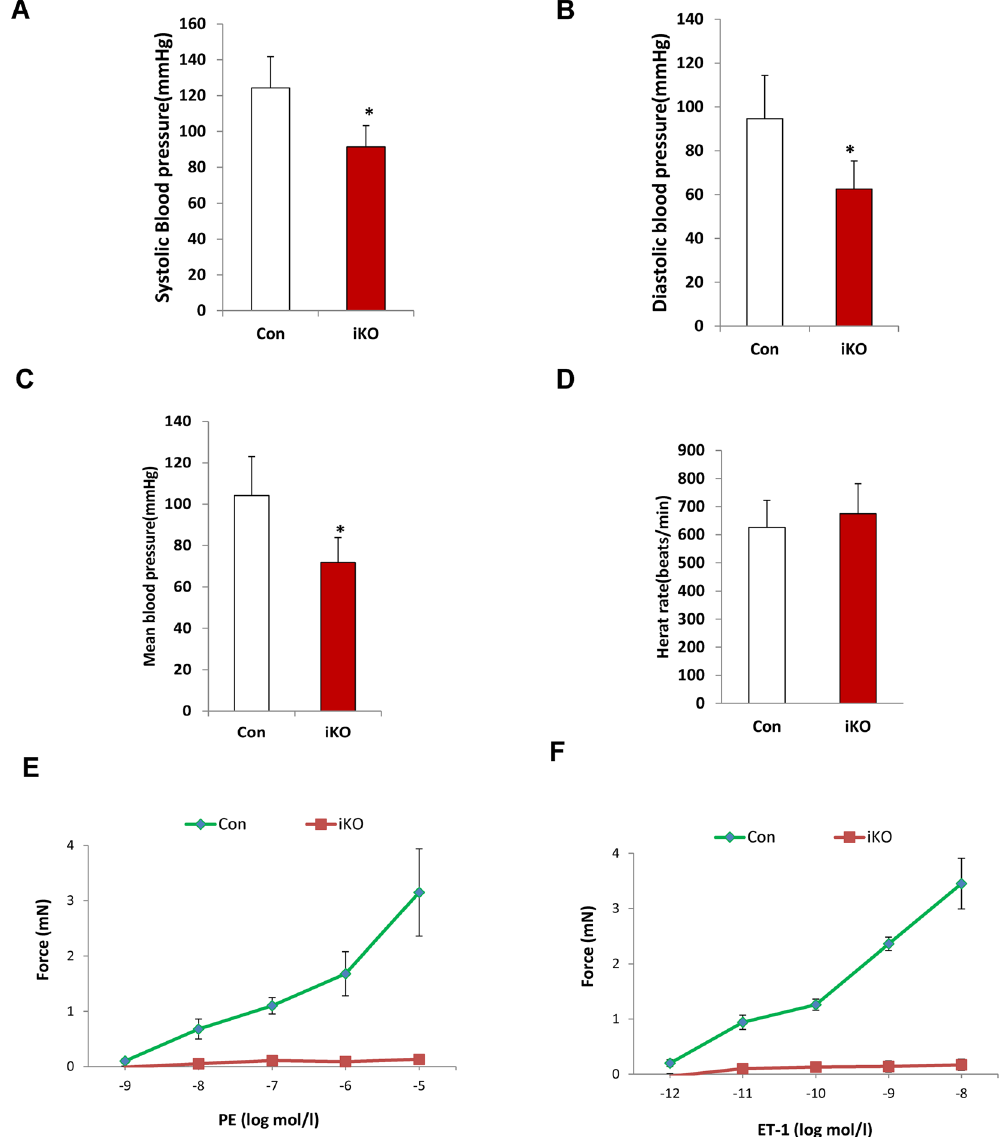
Figure 2. DGCR8iKO mice displayed reduced blood pressure and vascular reactivity. ( A,B,C ) Blood pressure was measured in DGCR8iKO and control mice one month after tamoxifen injection using tail-cuff method. DGCR8iKO mice displayed significantly reduced blood pressure including systolic ( A ), diastolic ( B ) and mean ( C ) compared to controls (N = 5 per group, * p < 0.05). ( D ) DGCR8iKO mice didn’t display significant differences in heart rate compared to controls. ( E and F ) The vascular reactivity was measured in thoracic aorta isolated from DGCR8iKO and control mice using a wire myography. DGCR8iKO mice displayed diminished vascular response to PE ( *** p < 0.001) and ET-1 ( *** p < 0.001),